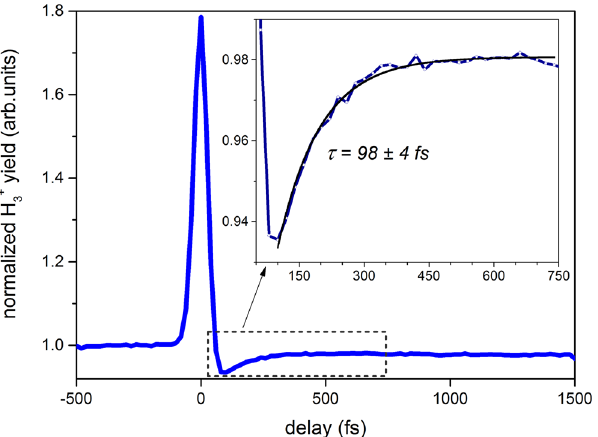
Figure 5. Normalized H 3 + yield (blue solid line) from dissociative ionization of CH 3 OH as a function of applied time delay between the pump and probe pulses. Normalization was performed with respect to the yield at negative time delays. (Inset) Magnified view of the normalized yield in the region of the dashed rectangle is shown together with an exponential fit (black solid